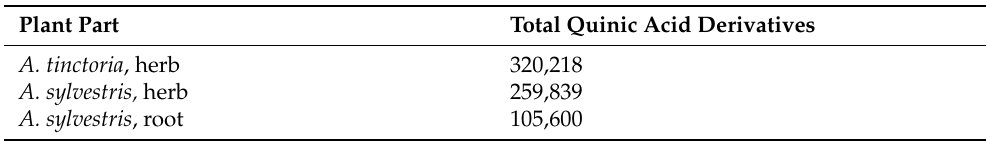
Table 6. Total quinic acid derivatives, estimated as total area of MS2 = 191 peaks on LC–MS